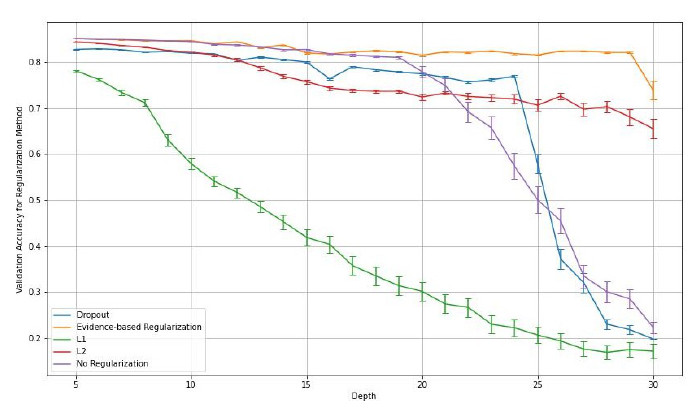
Figure 7. Validation accuracy (and standard error) for different regularization methods for a network with width =